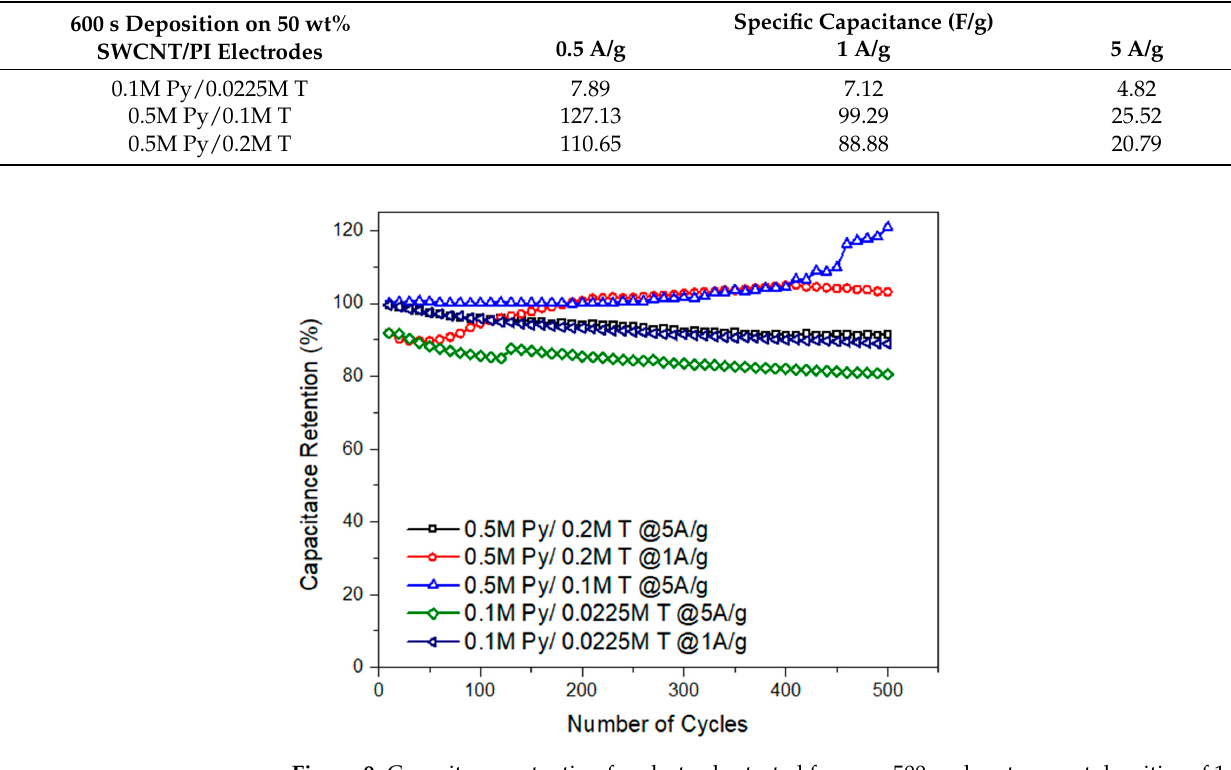
Table 2. Summary of specific capacitance obtained from charge–discharge cycles at 0.5, 1, and 5 A/g.